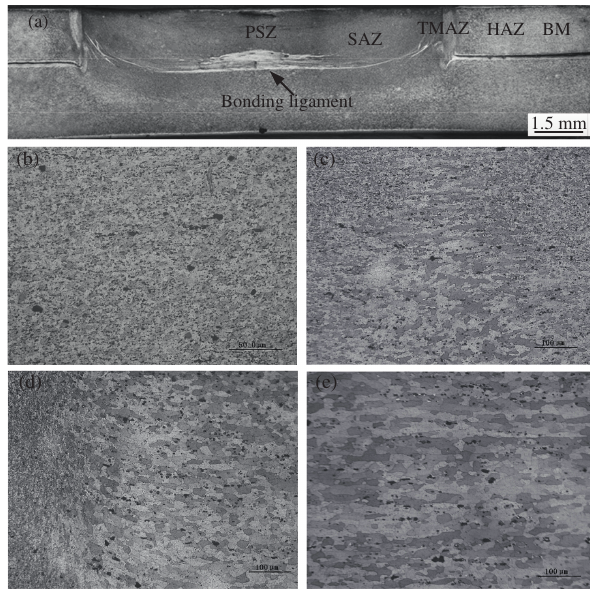
Figure 8: Microstructure of RFSSW joint: (a) cross section, (b) SAZ, (c) PAZ, (d) TMAZ and (e) BM.